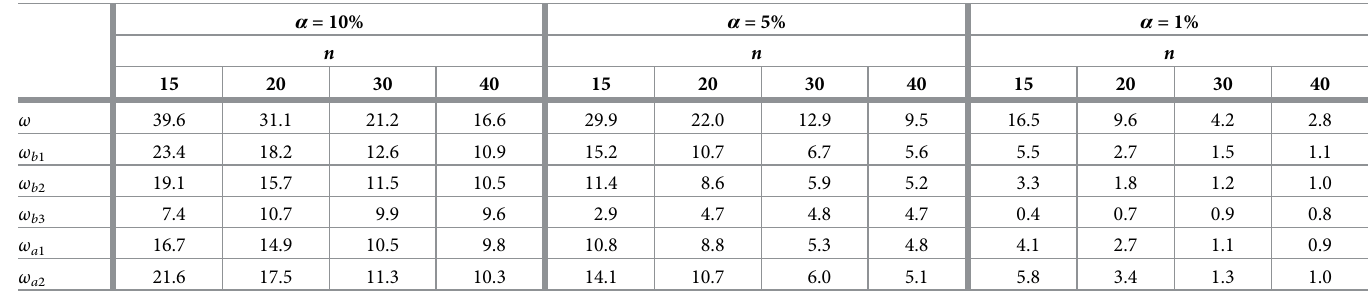
Table 2. Null rejection rates (%), H